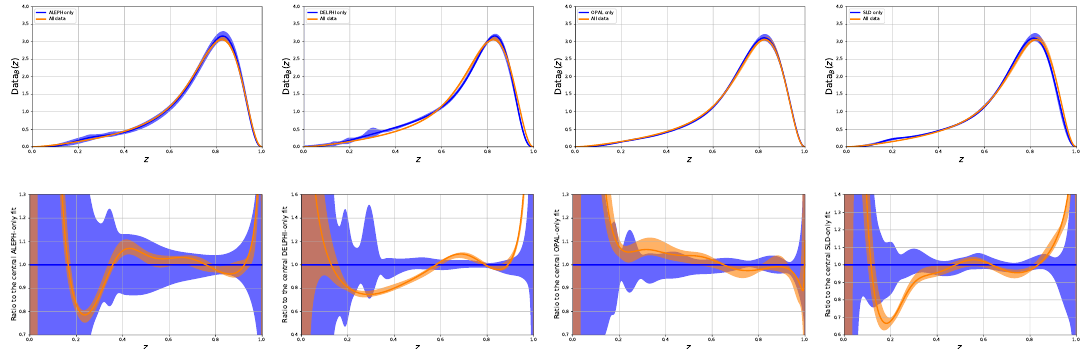
Figure 16 . NPFF fits from one dataset at a time (blue) versus the combined fit (orange). The four datasets are (from left to right): ALEPH, DELPHI, OPAL and